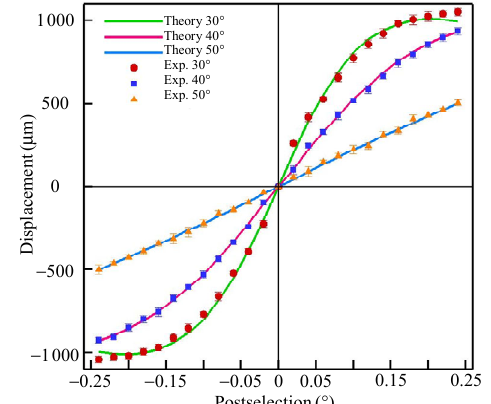
Fig. 3 Experimental and theoretical data at different incident angles of 30°, 40°, and 50°. The solid lines and dots represent the theoretical results and experimental data, respectively. We measured the beam displacement every 0.02° from − 0.24° to 0.24°.